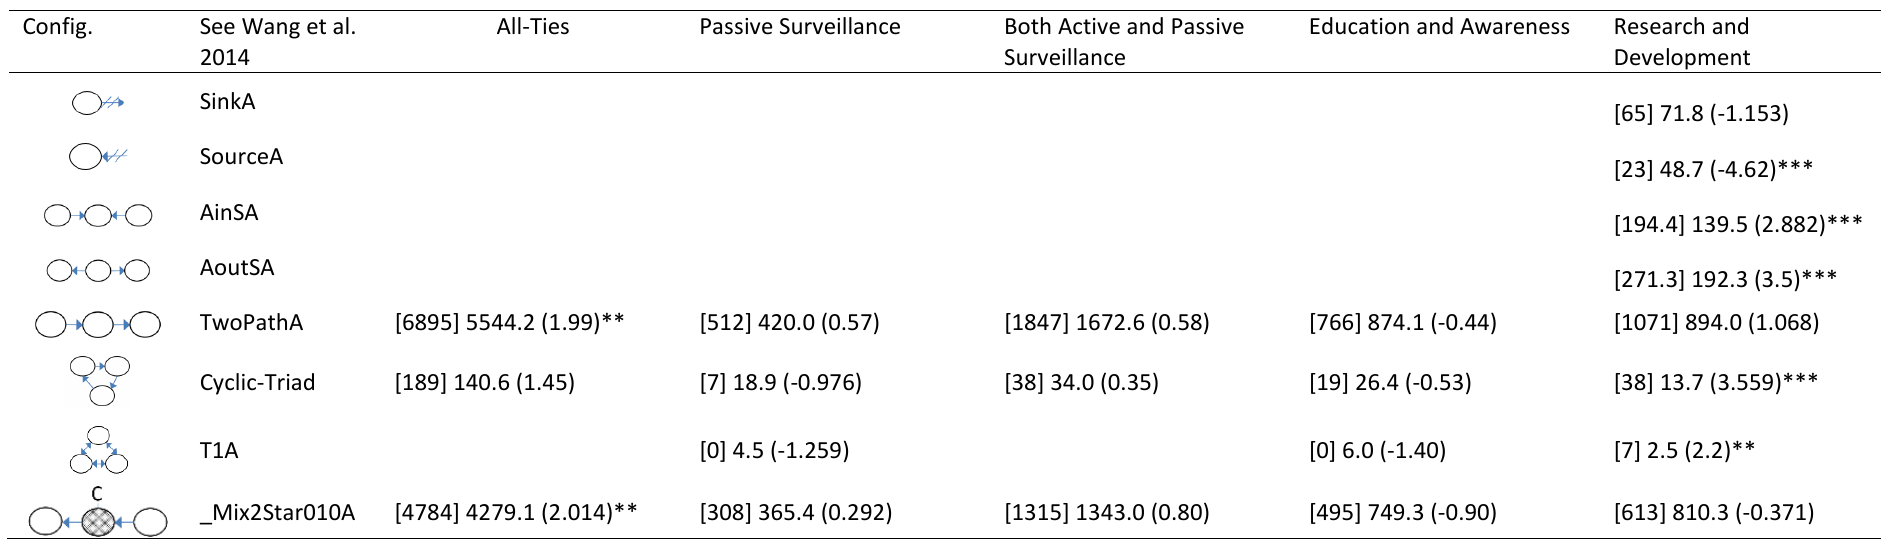
Table A1.2: Goodness-of-fit. Selected parameters in addition to fitted configurations from Table A1: Count, average from simulated graphs, t-score for difference, */**/*** signifying 90/95/99% significance. Note all fitted parameters reports <0.2 t-scores (Table A1). Only configurations where model convergence was not achieved are shown here.